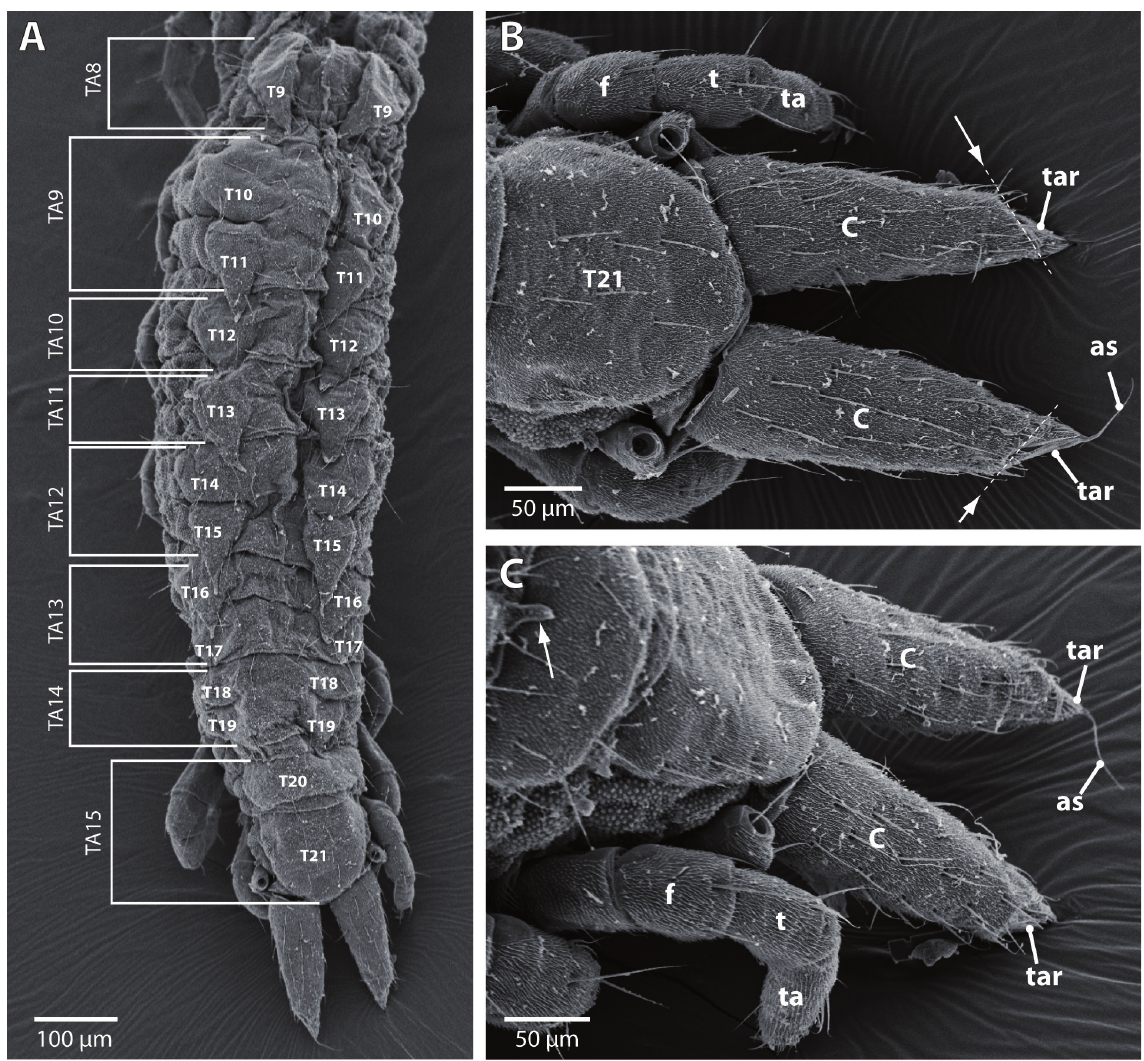
Fig. 10. Remysymphyla spinosa sp. nov. A . Posterior part of the trunk of the holotype, tegal areas 8-15 ( TA8-TA15 ) ( fide Domínguez Camacho 2009: 108, fig. 4 ), corresponding to tergites 9-21 ( T9-T21 ). Doubled labeling of tergites shows partial sclerotization. B . Last tergite ( T21 ), last pair of legs and cerci ( C ) of holotype, dorsal view. Arrows , diagonal limit between cerci sensu stricto and terminal areas ( tar ); as , apical seta; f , femur; t , tibia; ta , tarsus of the last right leg. C . Last tergites, last pair of legs and cerci ( C ) of holotype, lateral view. Arrow , digitiform projection of tergite 19; as , apical seta; f , femur; t , tibia; ta , tarsus of the last left leg; tar , terminal area of the